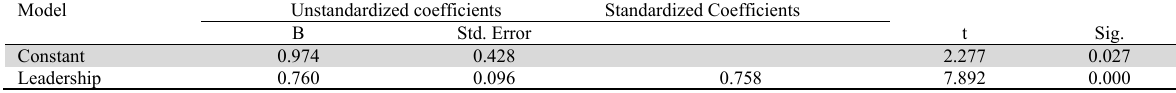
Coefficient Test Result of Path from Leadership to Job Satisfaction